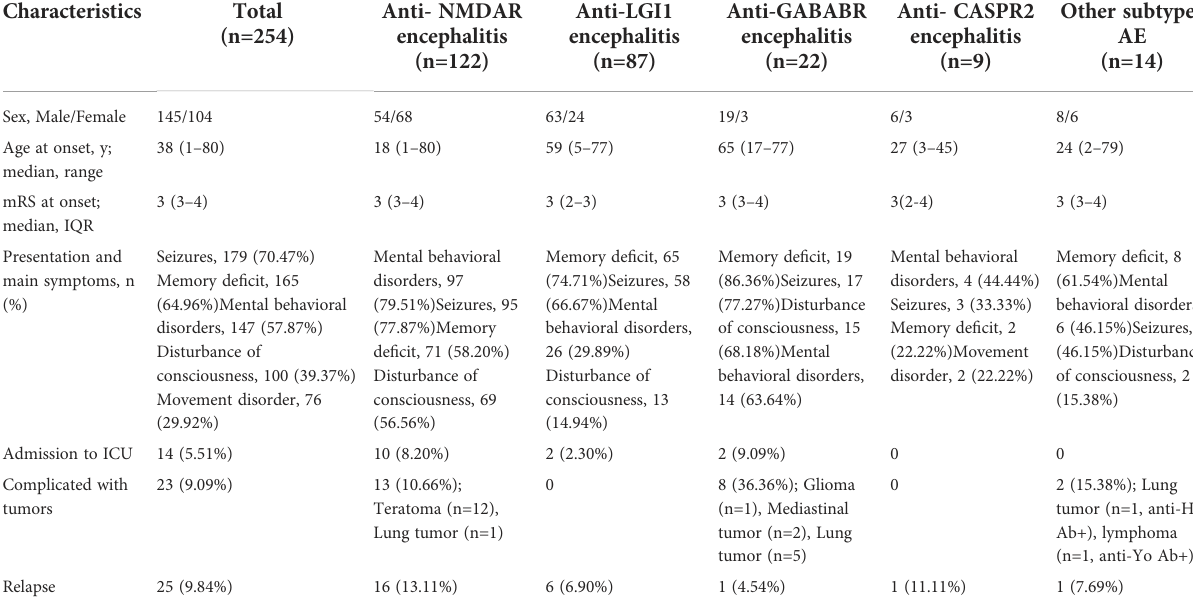
TABLE 3 Clinical characteristics of patients with single anti-neuronal antibodies (n=254).